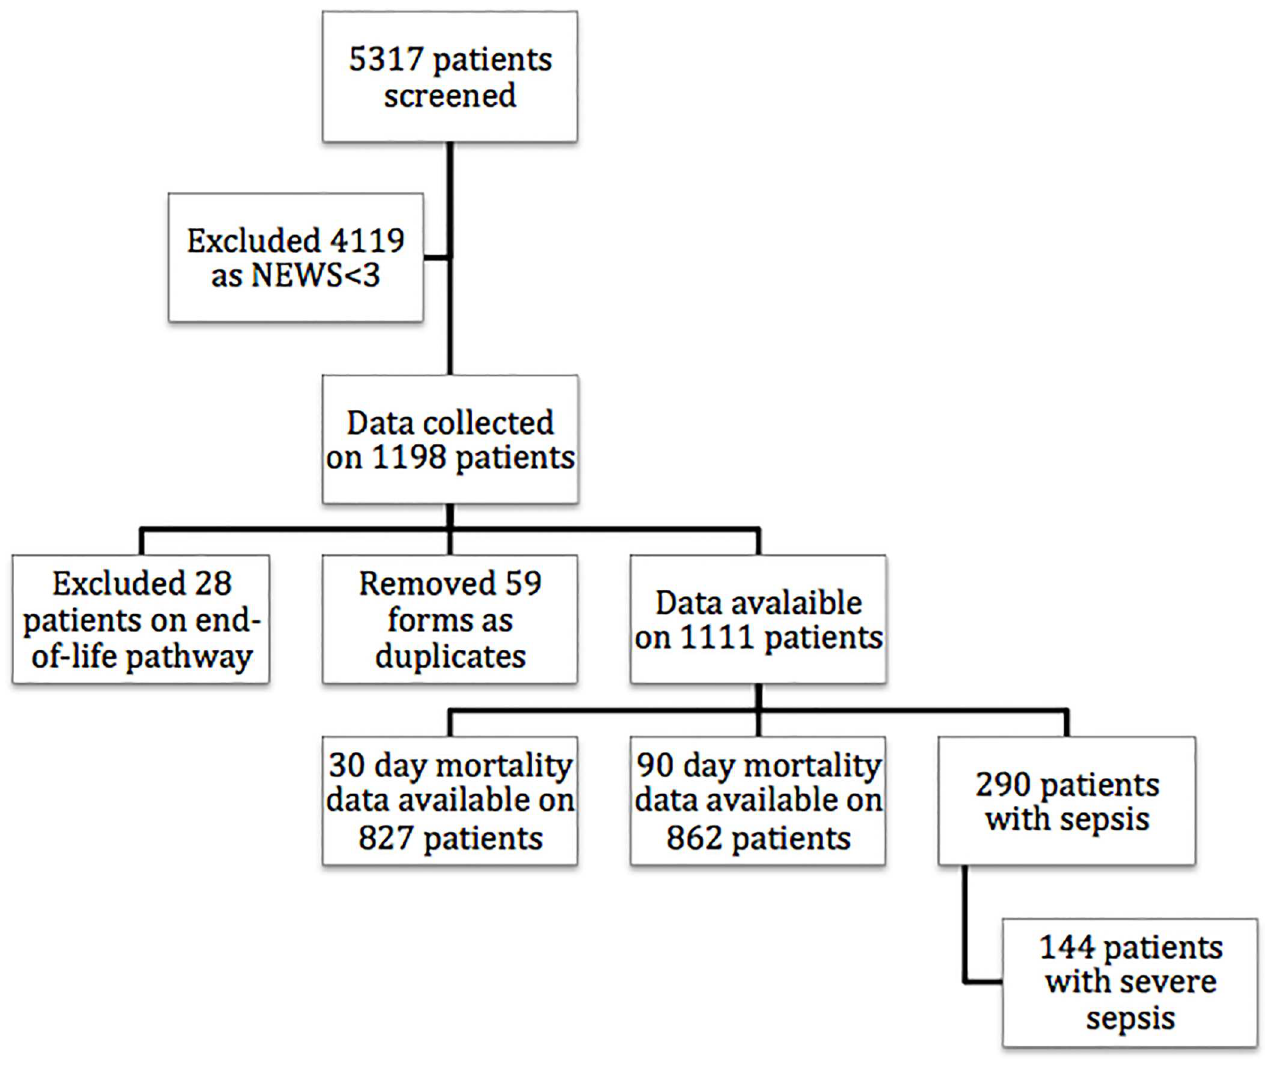
Fig 1. Organisational flowchart of the study